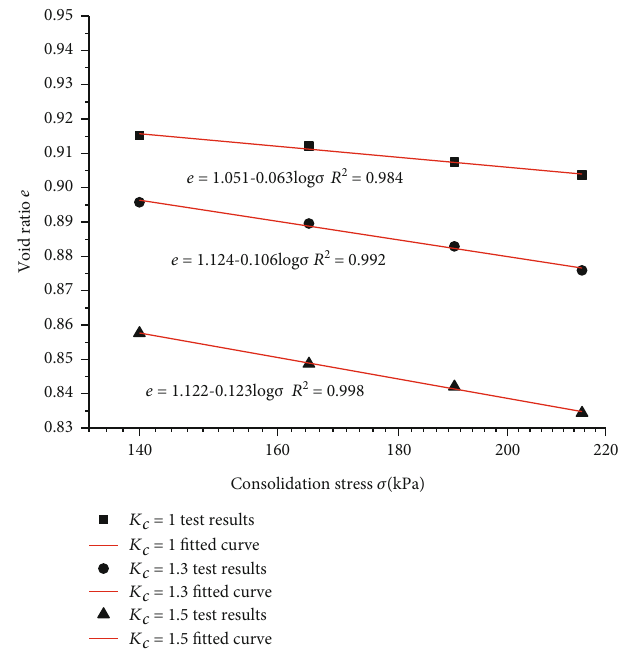
Figure 11: e ‐ log σ curve.